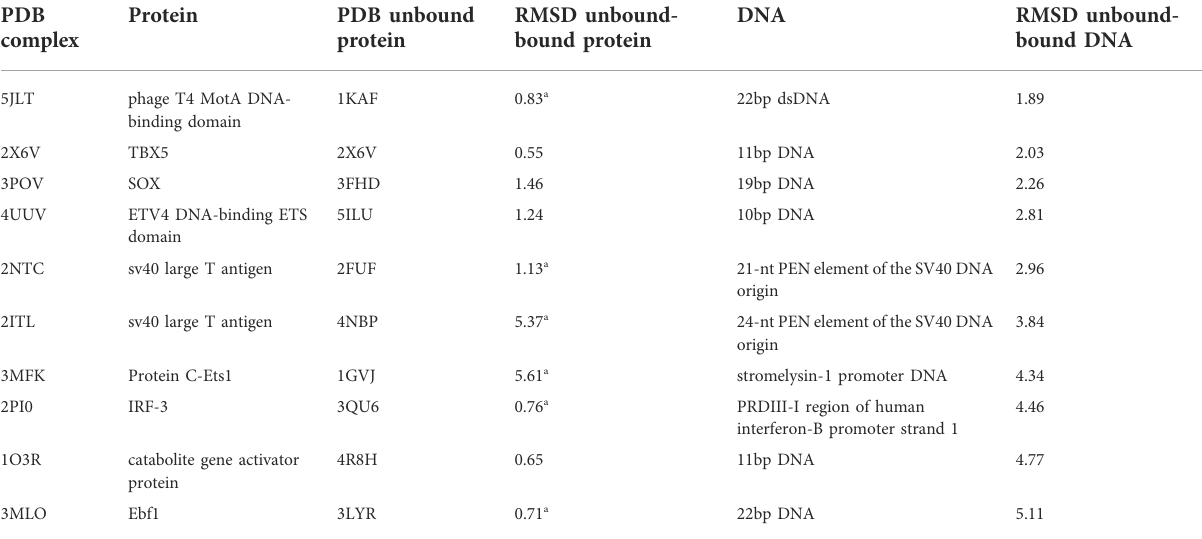
DNA RMSD unbound-